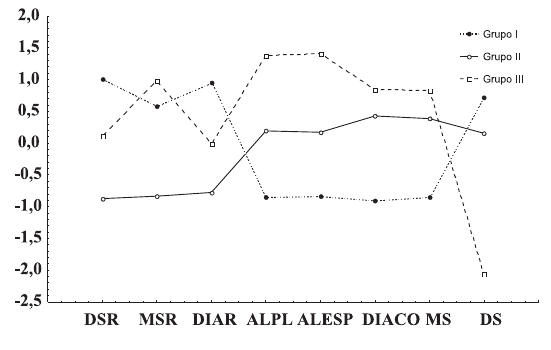
Figura 4. Dispersão (gráfico biplot ) da produtividade de milho (Mg ha -1 ) em diferentes condições de compactação do Latossolo Vermelho de textura média. PROD: produtividade, DSR: densidade radicular, MSR: matéria seca das raízes, DIAR: diâmetro radicular, ALPL: altura de plantas, ALESP: altura de inserção da espiga, DIACO: diâmetro do colmo, MS: matéria seca das plantas